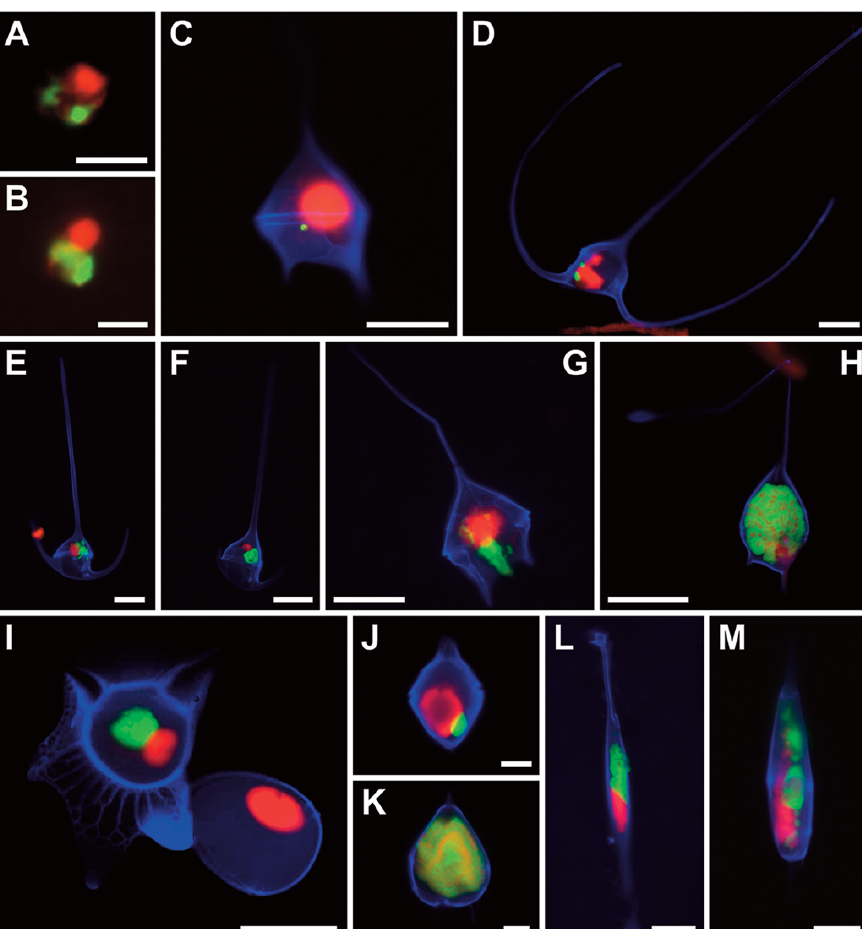
Fig. 4. Micrographs of dinospores (A, B) and infected dinoflagellates (C–M) observed under UV excitation. The cell nucleus (red), the theca (blue) of the dinoflagellates and the fluorescence of the probe targeting the cytoplasm of Amoebophryidae (green) are shown. Different maturation stages have been observed. (C) Neoceratium pentagonum with a dinospore inside; (D) Neoceratium trichoceros , the green area attached to the nucleus indicates that the infection is started; (E) Neoceratium tripos , (F) Neoceratium pulchellum and (G) Neoceratium pentagonum as an illustration of different progressive infection stages; (H) Neoceratium minutum with a mature trophont having the typical beehive-shape of Amoebophrya parasite, small red spots are the multiple nuclei of this stage; (I) infected Ornithocercus carolinae together with non-infected Prorocentrum sp.; infected cells of (J) Gonyaulax polygramma , (K) Podolampas bipes with a beehive-shape of the trophont presenting an internal cavity clearly visible, (L) Amphisolenia globifera and (M) Podolampas spinifera with a atypical trophont feature. Scale bars (A) , (B) = 5µm; (C) , (D) , (E) , (F) , (G) , (H) = 50µm; (I) = 10µm; (J) , (K) , (L) , (M) =